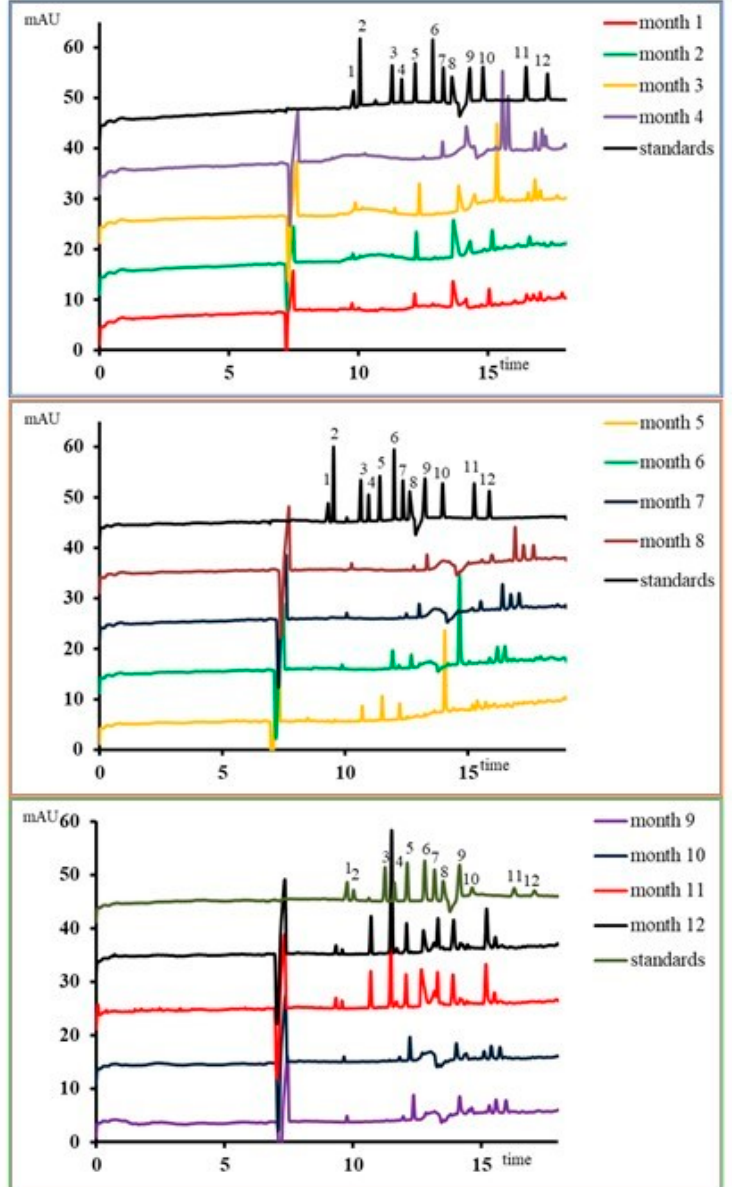
Figure 3. The amount of acetic, propionic, butyric, and lactic acids after in vitro long ‐ term stevio ‐ side consumption. Standards: 1—formic acid; 2—oxalic acid; 3—succinic acid; 4—malic acid; 5— tartaric acid; 6—acetic acid; 7—propanoic acid; 8— butyric acid; 9—lactic acid; 10—benzoic acid; 11— phenyllactic acid; 12—OH phenillactic acid.